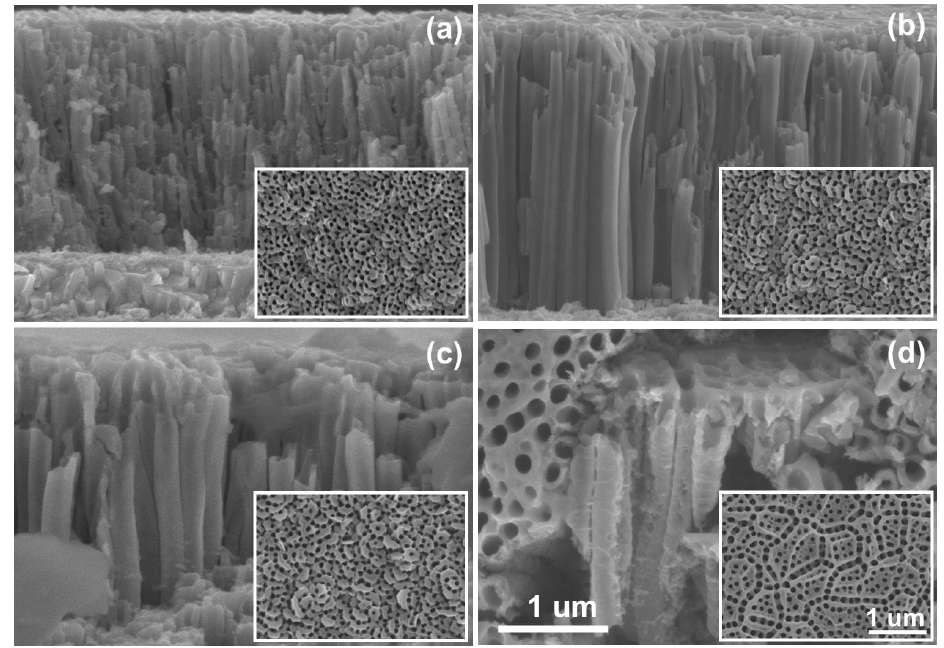
Figure 6. Cross-sectional and corresponding surface (inserts) SEM images of the TiO 2 nanotubes (TNT) arrays grown from titanium films deposited at RT ( a ), 150 °C ( b ), 300 °C ( c ), and 450 °C ( d ).